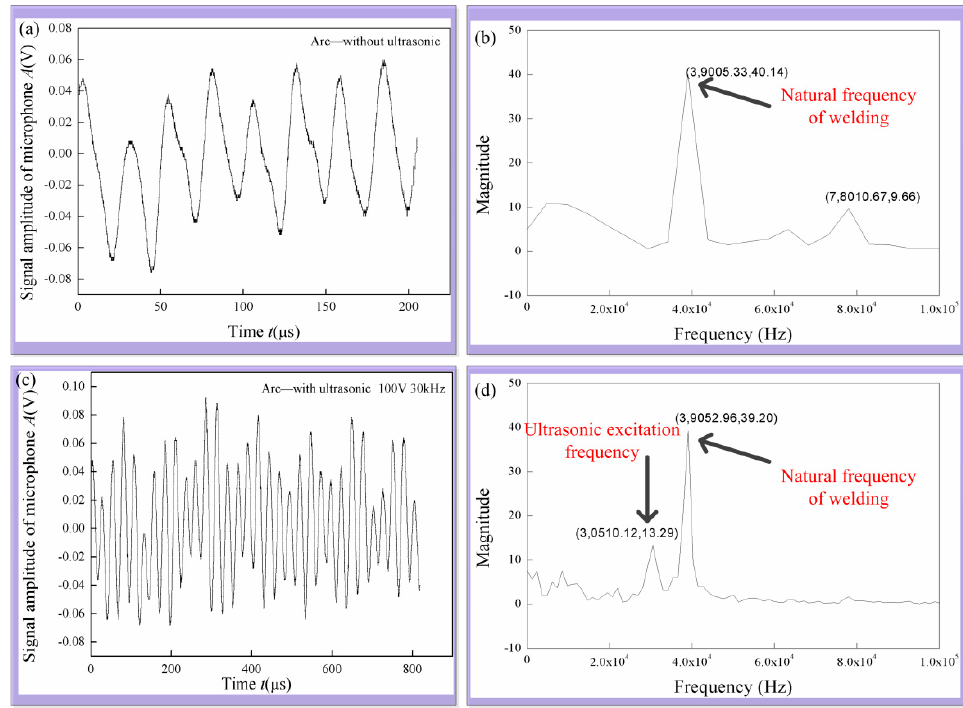
Figure 4. Acoustic signal detection around the arc: ( a ) original MIG, time-domain signal; ( b ) original MIG, frequency-domain signal; ( c ) 30 kHz ultrasonic coupling, time-domain signal; ( d ) 30kHz ultrasonic coupling, frequency domain signal.